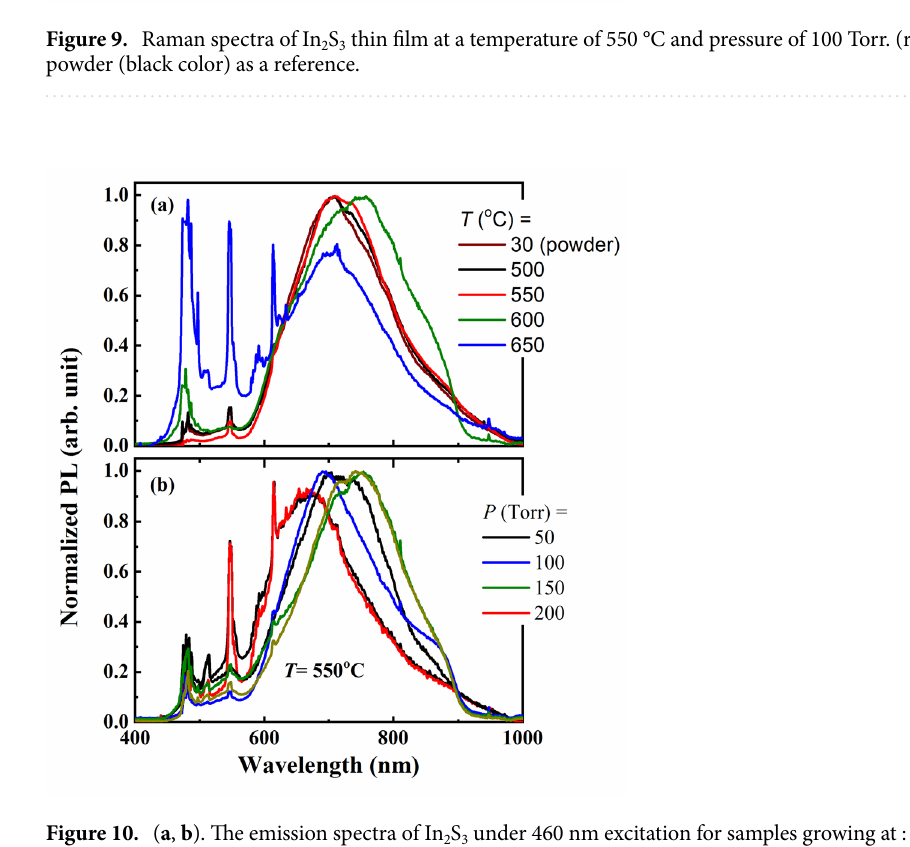
Figure 10. ( a , b ). The emission spectra of In 2 S 3 under 460 nm excitation for samples growing at : ( a ) pressure of 100 Torr with different annealing temperatures (500–650 °C) and ( b ) temperature of 550 °C with different pressures (50–200